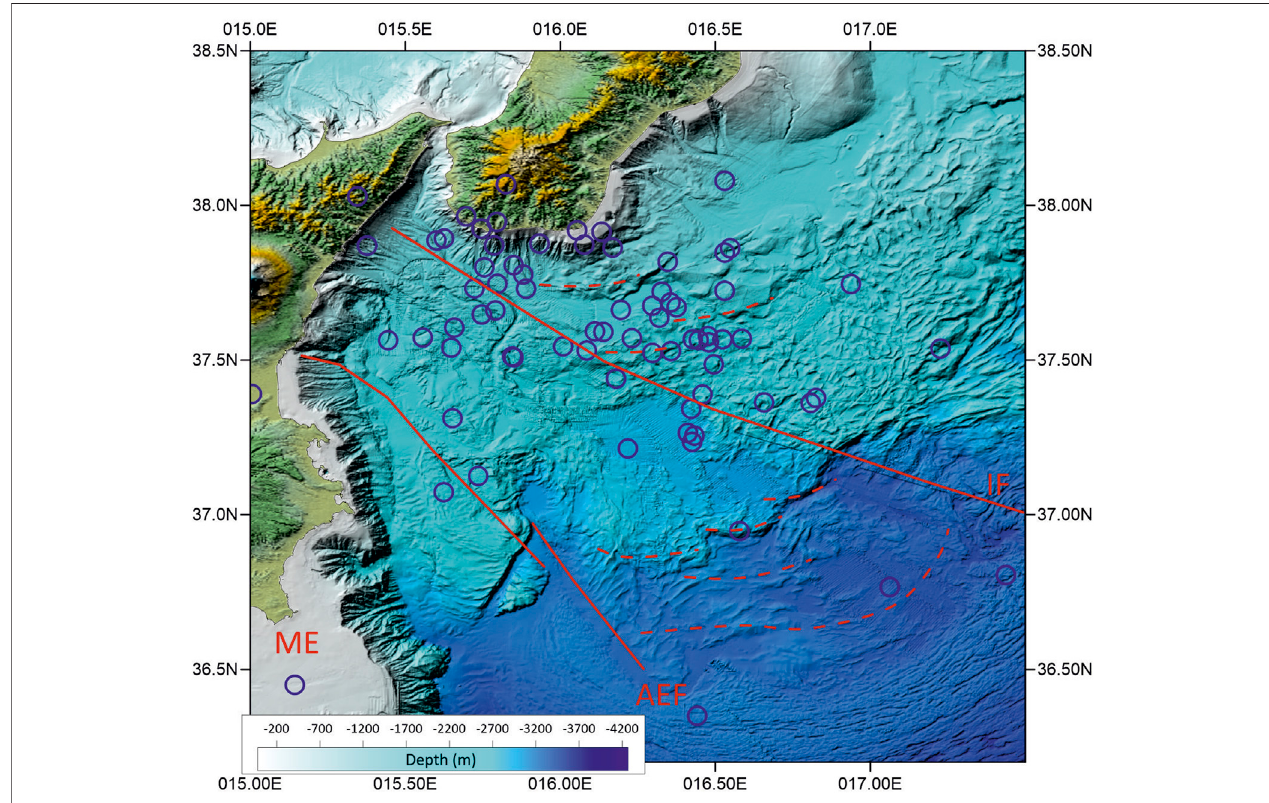
FIGURE 8 | Distribution of epicentres of the 76 earthquakes recorded only by the OBS network. Parameters of location for these events are listed in Supplementary Table 3 . The main tectonic structures including the Alfeo-Etna Fault and Ionian Fault (Polonia et al., 2016) are sketched in red. Bathymetric map was obtained from high resolution multibeam collected during the oceanographic cruise of SEISMOFAULTS project (Cuffaro et al., 2019; Billi et al., 2020) and merged with DEMs from https://portal.emodnet-bathymetry.eu/.